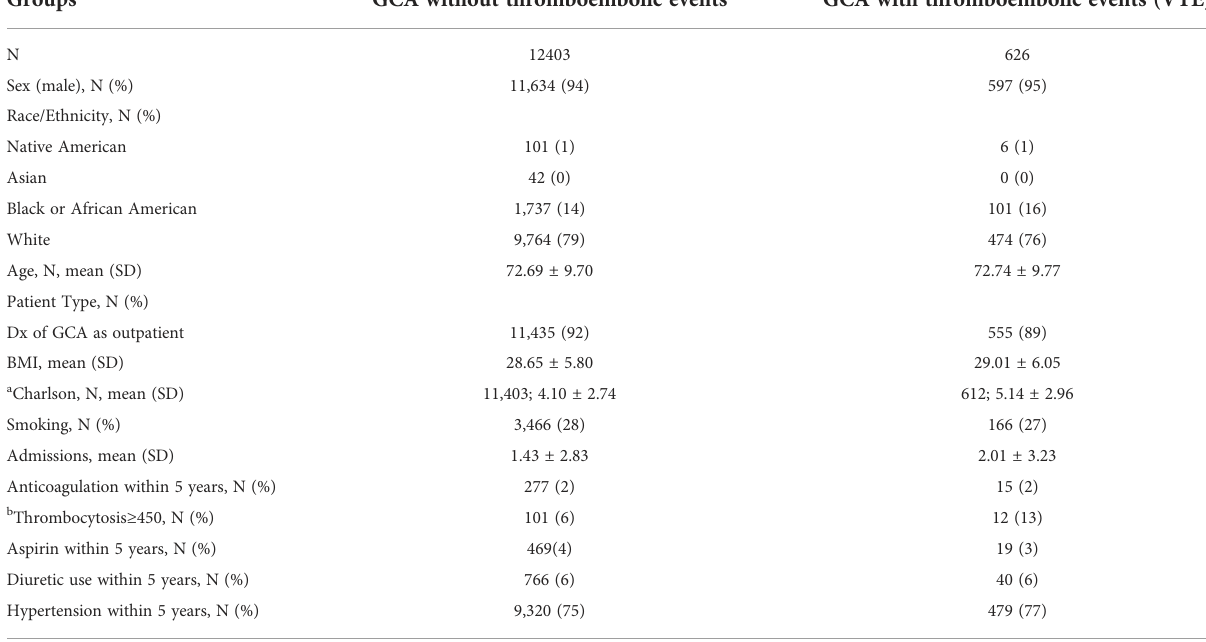
TABLE 1 Baseline demographic characteristics of GCA patients without and with thromboembolic events.